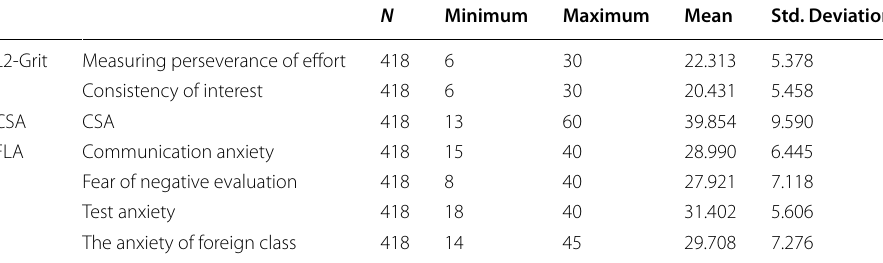
Table 1 Descriptive statistics